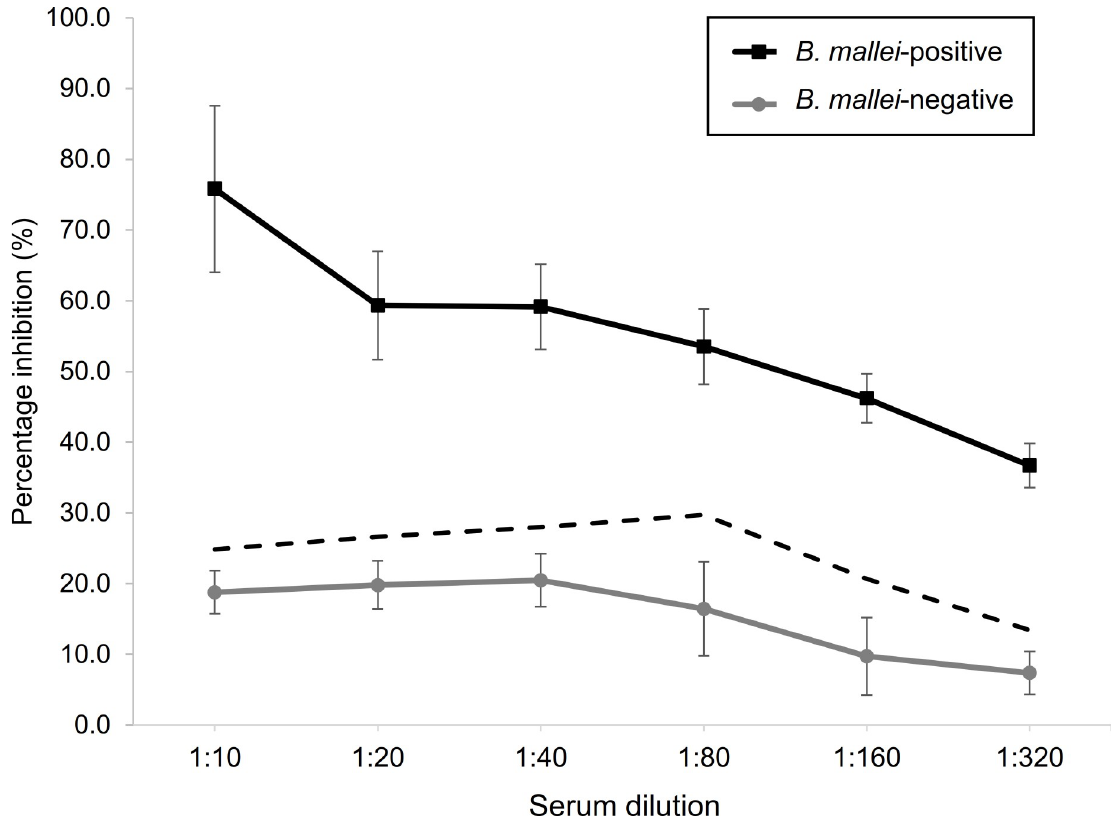
Fig 3. Lipopolysaccharide (LPS)-based competitive ELISA (cELISA) in the presence of 2 ng of B . mallei LPS and 3.5 ng/ μ L mAb B5 with varying dilutions of B . mallei -positive and negative sera. cELISA values calculated as percentage inhibition (PI) of mAb B5 binding. Serum from a glanders-seropositive horse (SE1719.4/19) from a glanders outbreak in Kuwait was used as the B . mallei -positive sample. Serum from a glanders-seronegative horse (ED18-0081-0001) from AFCD in Hong Kong was used as the B . mallei -negative sample. Dashed line indicates 2 standard deviations above the mean PI of the B . mallei -negative serum at each serum dilution.